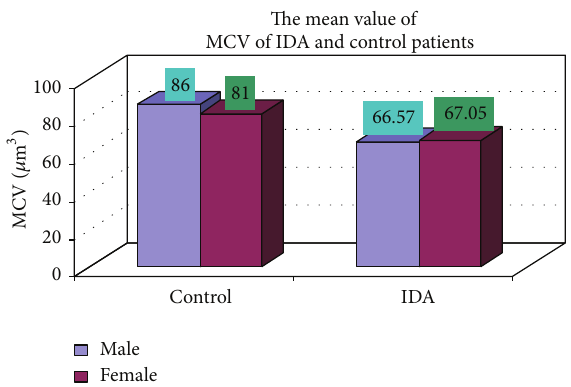
Figure 5: Showing the mean value of ESR of control and iron deficiency anaemia.